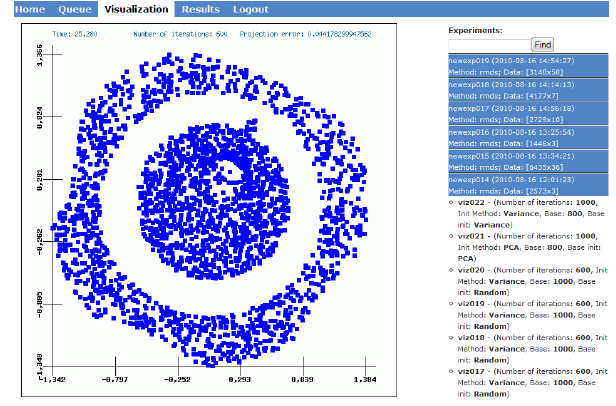
Figure 5. Client interface: visualization results.